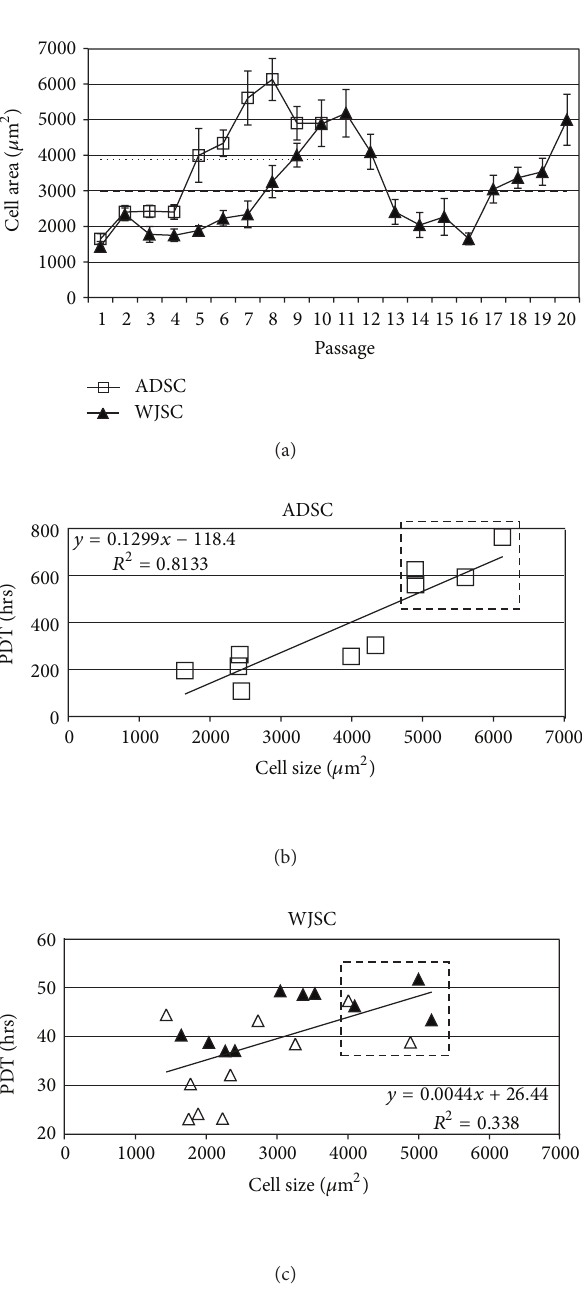
Figure 2: Variation in cell size (surface area in 𝜇 m 2 ) over time in culture and its association with proliferation kinetics. (a) Cell size (mean area ± SEM) as a phenotypic property of WJSC and ADSC during serial propagation. Dashed and long dashed horizontal lines denote mean cell size for ADSC (3876 𝜇 m 2 ) and WJSC (2926 𝜇 m 2 ), respectively; (b) regression analysis of ADSC size versus PDT at respective passages ( 𝑃 < 0.001 , Spearman r correlation coefficient = 0.915). Trendline equation and good- ness of fit ( 𝑅 2 ) are shown. Boxed data points correspond to ADSC with sizes over 3,880 𝜇 m 2 (top 25% of cells); (c) regression analysis of WJSC size versus PDT at respective passages ( 𝑃 < 0.01 , 𝑟 = 0.6 ). Open triangles, p.1–10; solid triangles, p.11–20. Trendline equation and goodness of fit (𝑅 2 ) are shown. Boxed data points correspond to WJSC with sizes over 4,600 𝜇 m 2 (top